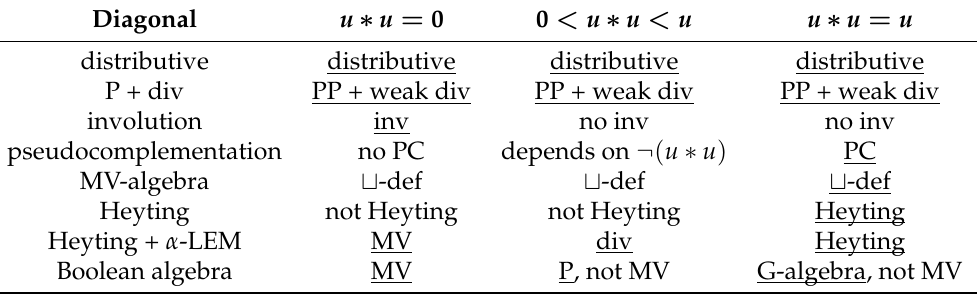
Table 3. Properties on triangle algebras and their